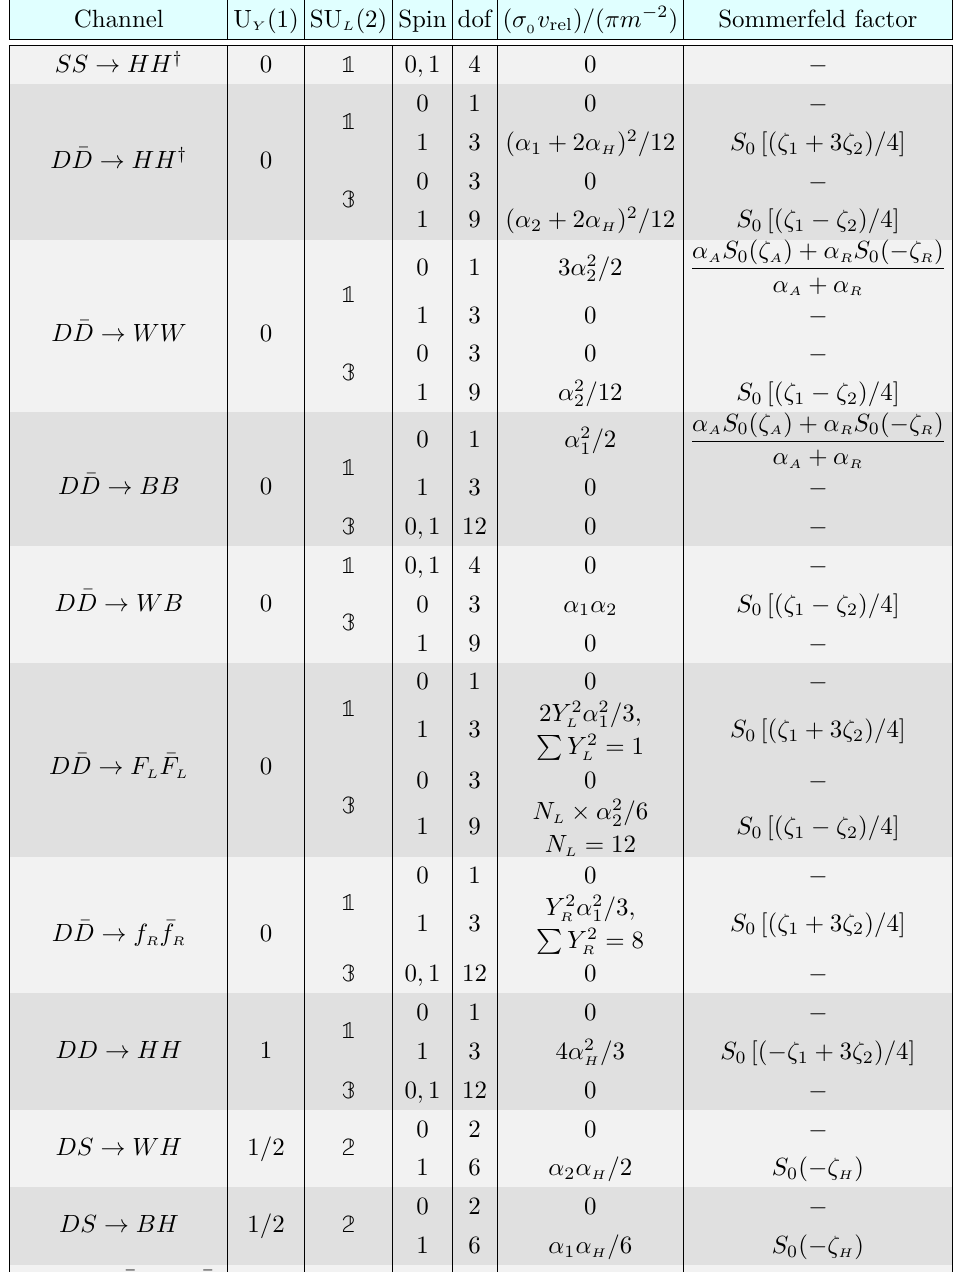
Annihilation processes, their tree-level s -wave velocity-weighted cross-sections σ and Sommerfeld factors. All σ are averaged over the degrees of freedom of the corresponding 0 v rel projected scattering state (5th column). For DD , σ 0 v rel includes the symmetry factor due to the identical initial-state particles. For the gauge-singlet spin-0 D ¯ D channels, see text for discussion. S 0 ( ζ ) and the various ζ parameters are defined in eqs. (2.18) and